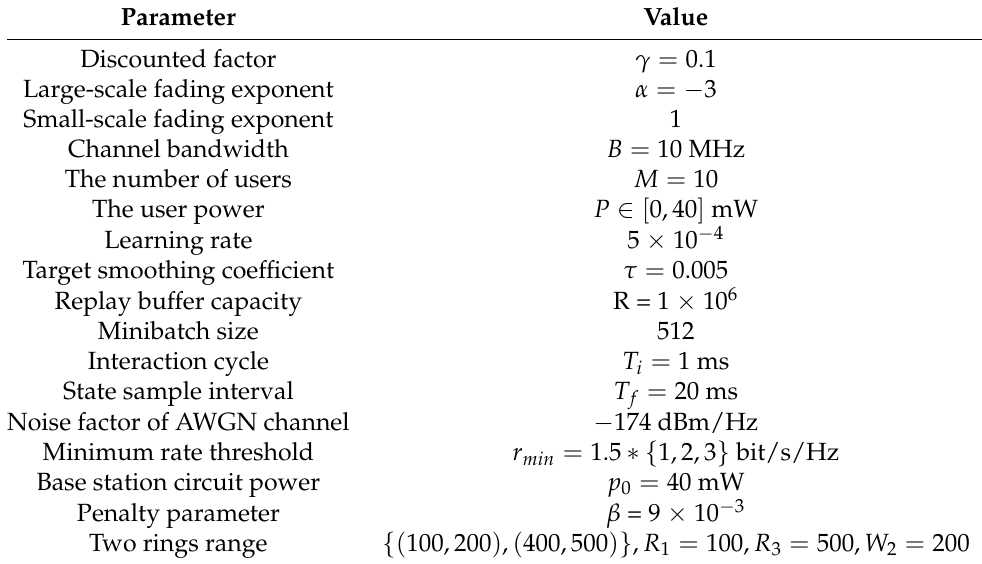
Table 1. Important parameters in the simulation setup.